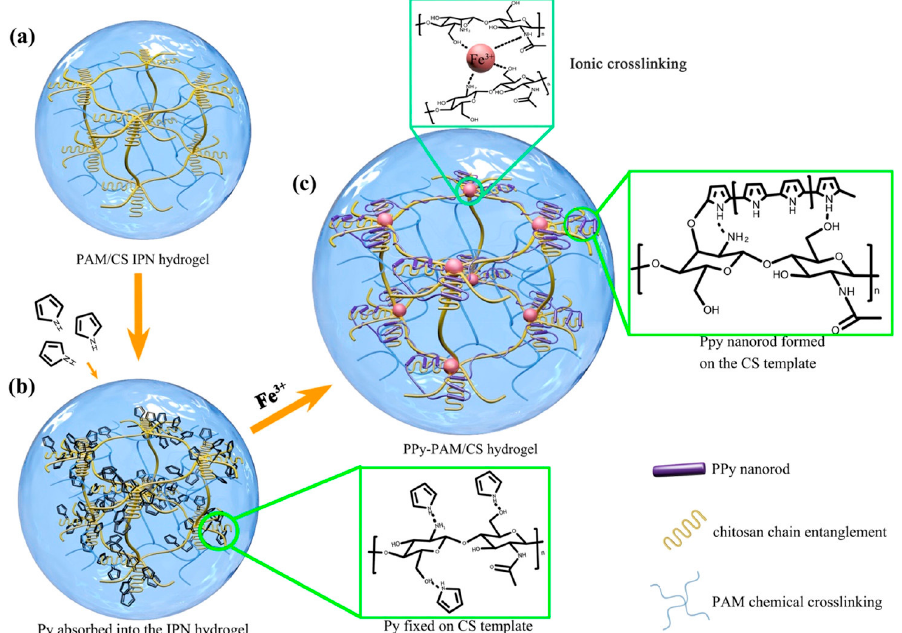
Figure 2. Schematics of the preparation of PPy composited conductive and tough hydrogels; ( a ) Synthesis of polyacrylamide/chitosan interpenetrating network (PAM/CS IPN) hydrogels; ( b ) Py absorption into IPN hydrogel fixed on CS chains and accumulated in the CS entanglement zone; ( c ) PPy in situ polymerization. Adapted with permission from Ref. [59]. Copyright © 2018 American Chemical Society.